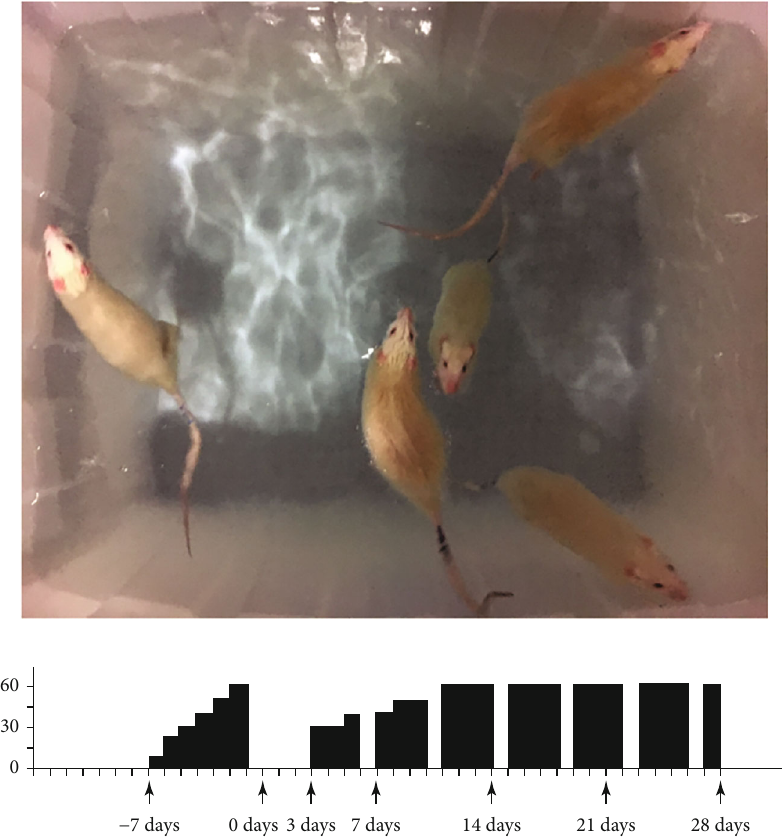
Figure 2: Protocol for swimming training. The training program involves one week of habituation to swimming before surgery and 4 weeks of formal swimming training after surgery. The black bar represents the time of training every day, and if there is no black bar, it means rest on that